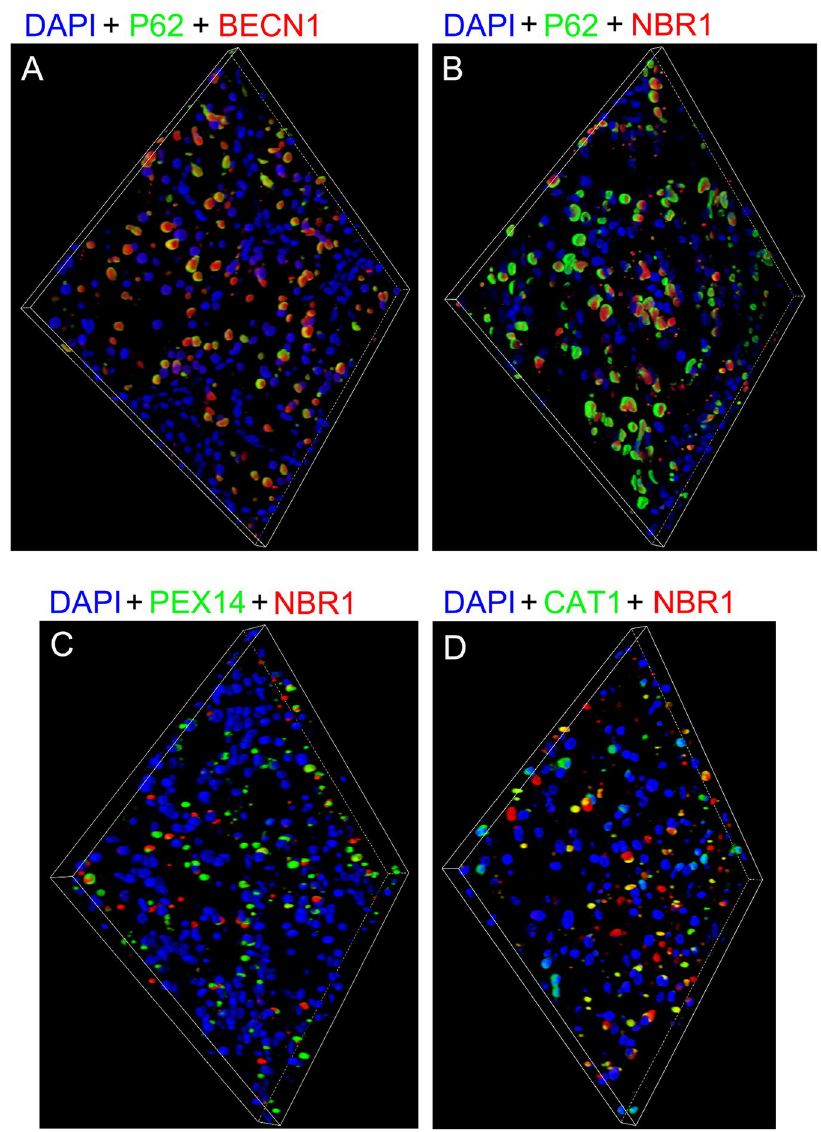
Figure 5. Three-dimensional reconstruction images of ECIs. ( A ) ECIs without NBR1 and peroxisomes. ( A – D ) ECIs comprising P62, BECN1, and NBR1 with peroxisomes partially or completely surrounding them.